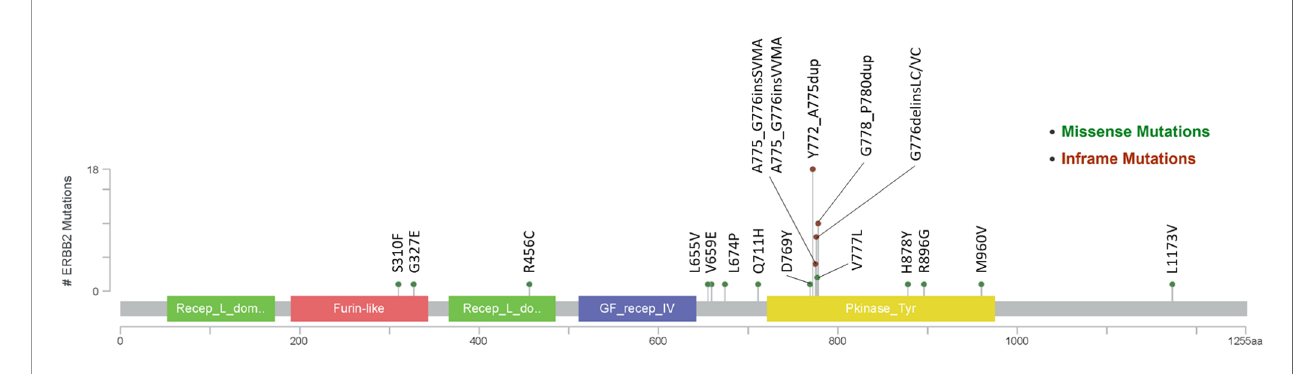
FIGURE 1 | HER2 mutational